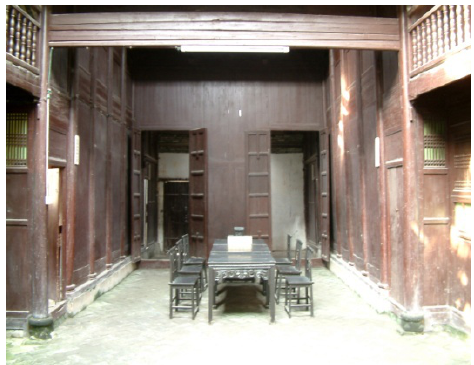
Figure 34. Hall photo (beneath roof lights)